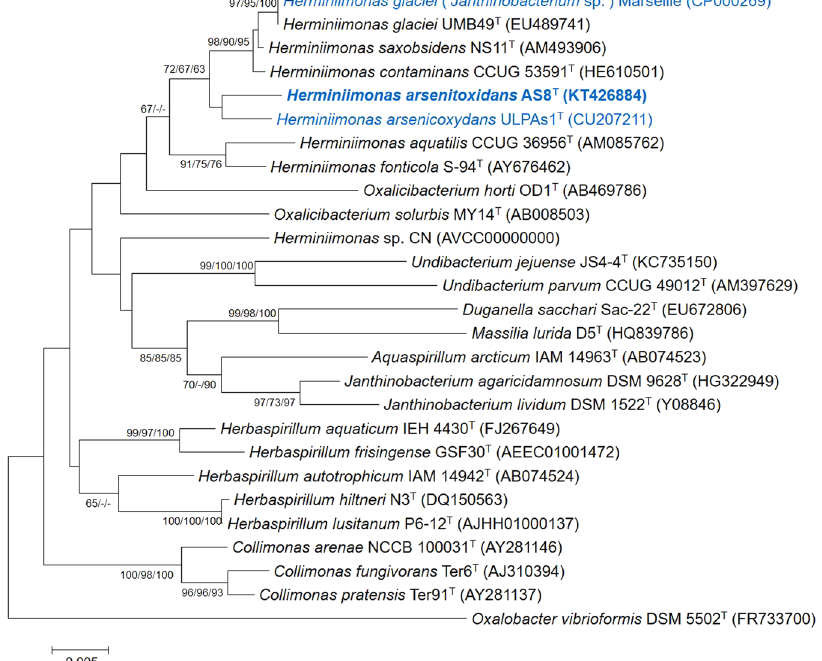
Figure 1. The phylogenetic tree of AS8 and Herminiimonas reference strains based on 16S rRNA gene sequences. The GenBank accession numbers are indicated in parentheses. Oxalobacter vibrioformis DSM 5502 T was used as an outlier. The tree was constructed using the neighbor-joining, maximum-likelihood, and maximum-parsimony methods. Bootstrap values are based on 1000 replicates; only bootstrap values above 60% are shown. Scale, 0.005 substitutions per nucleotide position. Color blue denotes the available complete genome